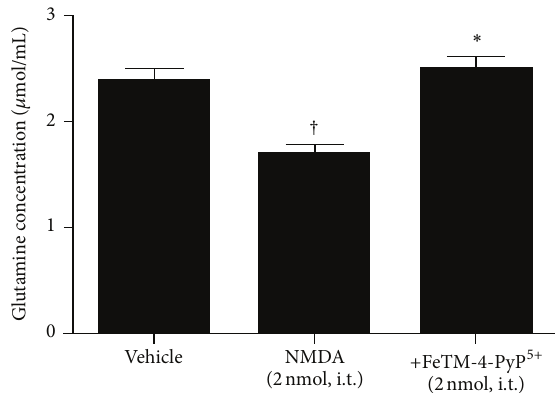
Figure 6: Inhibition of NMDA-induced hyperalgesia by FeTM-4-PyP 5+ (2 nmol, given 15 min before NMDA) modulates GS activity. The amountofglutamineishighlydecreasedinanimalstreatedwithNMDAwhileitisrestoredbyFeTM-4-PyP 5+ treatment.Resultsareexpressed as mean ± SEM for 3 rats; † 𝑃 < 0.001 compared to vehicle; ∗ 𝑃 < 0.001 compared to NMDA alone.